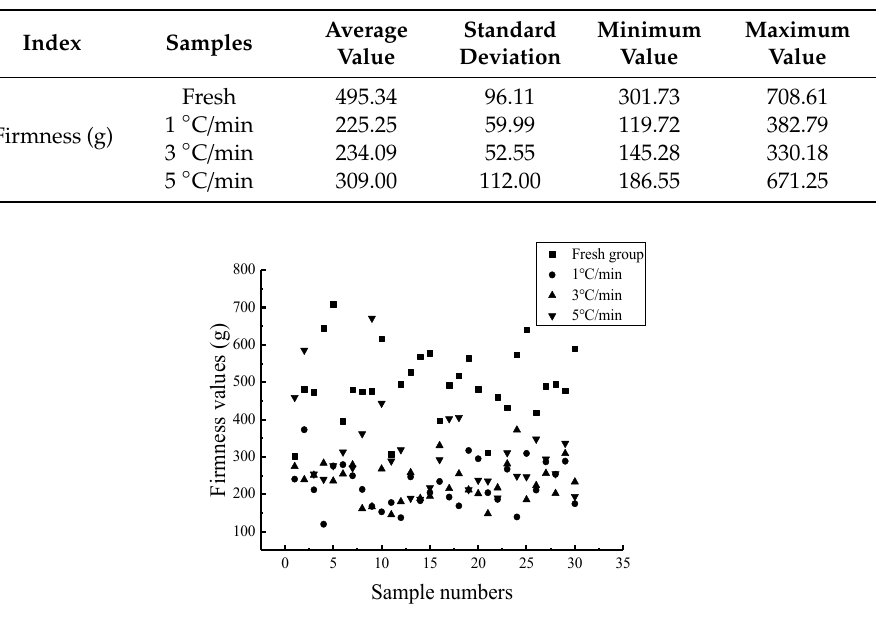
Figure 8. Scatter plot of the distribution of the firmness values of the Nanguo pears.